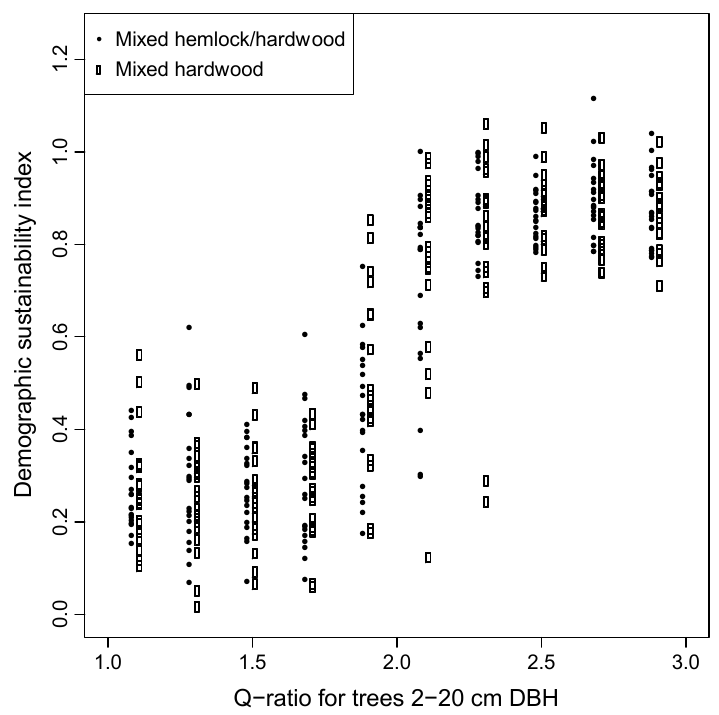
Figure 9. Pooled-species demographic sustainability index as a function of maximum q-ratio. Q was held constant within a simulation in the 2–22 cm diameter classes. Simulations were conducted for 1000 years and replicated 20 times starting from uneven-aged old-growth stands (Group 3 simulations).